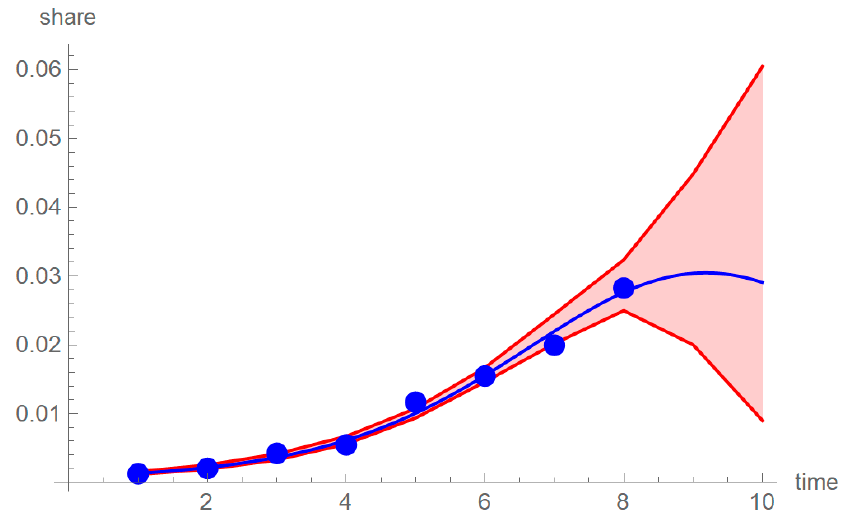
Figure 4. Market shares of electric cars in Austria from 2012 to 2019. Note: blue dots are market share data, the blue line is estimate from Equation (2), using the curve from Figure 3, and the red band restricts the range of the derivatives of the growth curves red exponent pairs (Figure 1); plot using Mathematica 12.1.